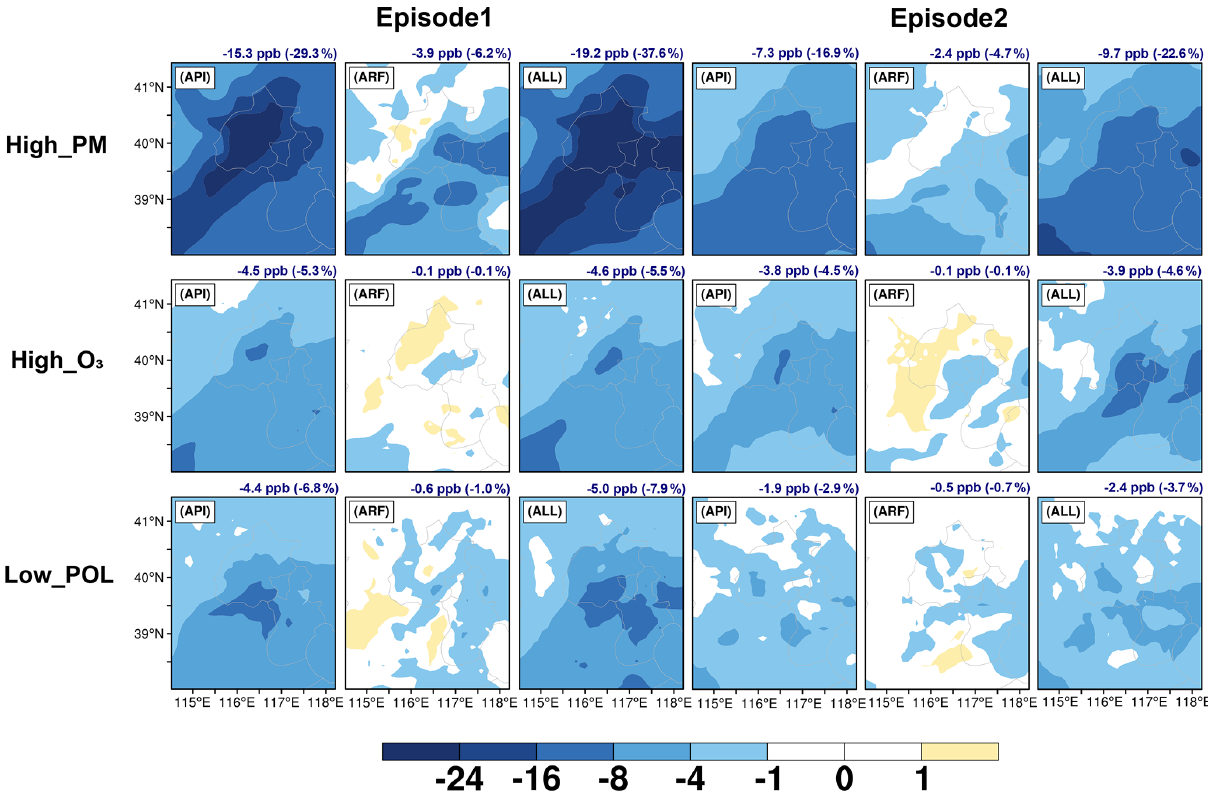
Figure 9. The changes in surface-layer O 3 due to aerosol–photolysis interaction (API), aerosol–radiation feedback (ARF), and the combined effects (ALL; API + ARF) in the daytime (08:00–17:00LST) of 7–12 October 2014 (High_PM_Episode1), 7–11 April 2014 (High_PM_Episode2), 13–18 June 2016 (Low_POL_Episode1), 13–17 July 2016 (Low_POL_Episode2), 15–21 June 2017 (High_O 3 _Episode1), and 12–17 July 2017 (High_O 3 _Episode2). The changes (percentage changes) in O 3 concentrations caused by API, ARF, and ALL, averaged over the entire simulated domain, are also shown at the top of each